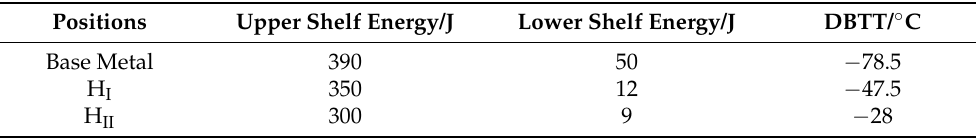
Table 3. The primary information of ductile–brittle transition